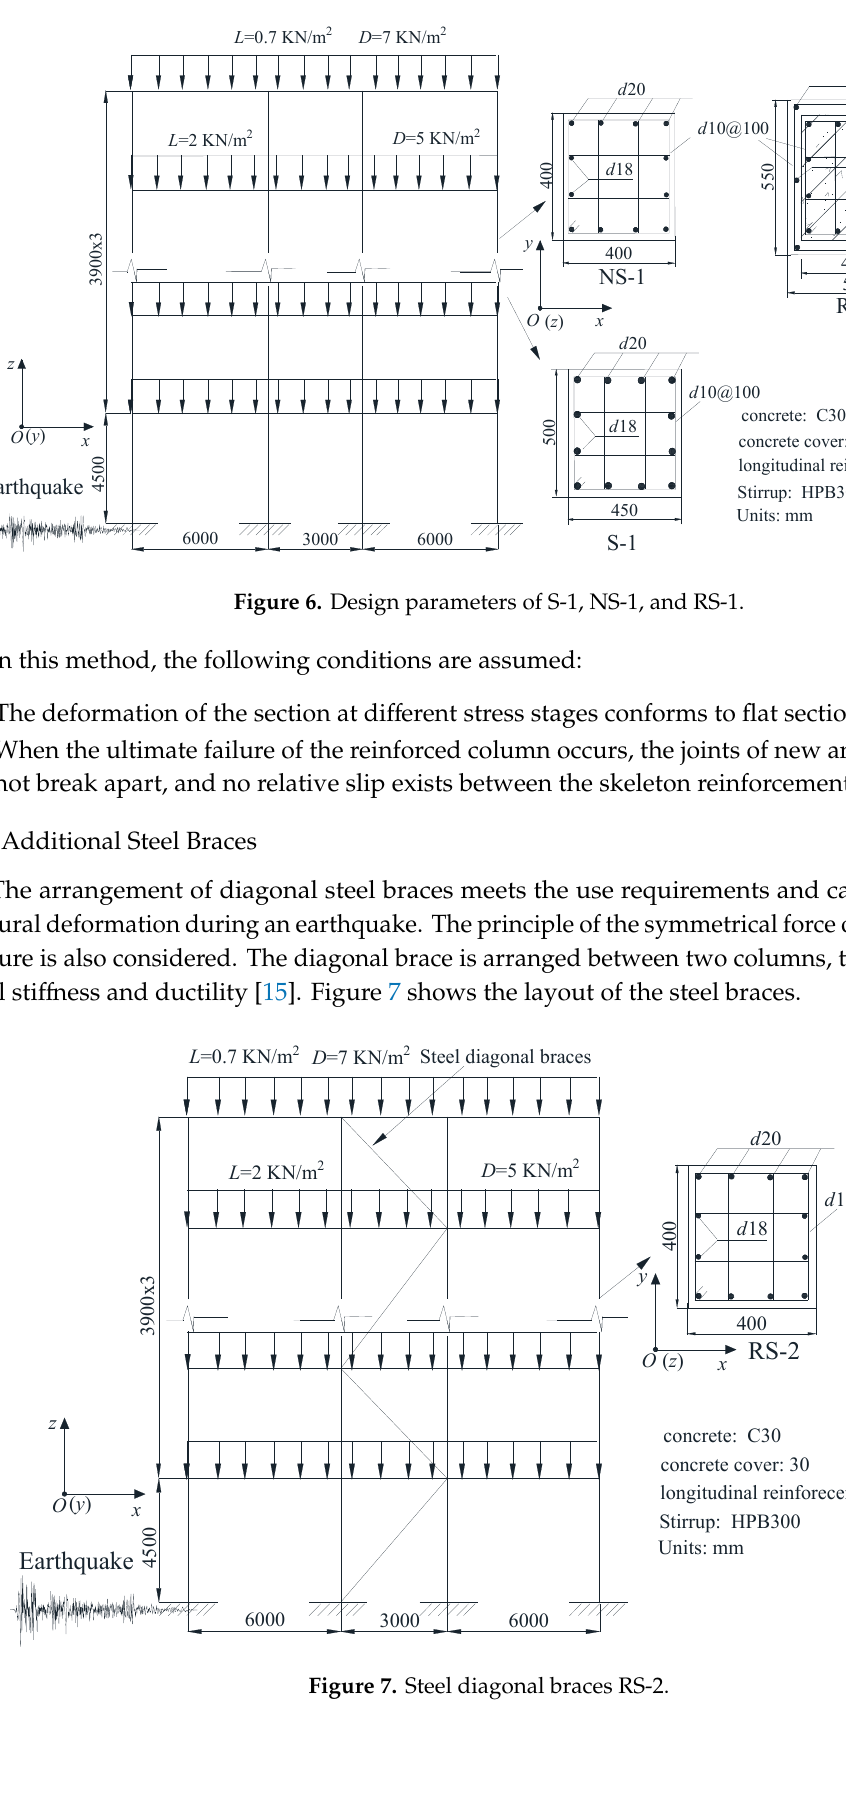
Figure 5. Enlarging the column section.